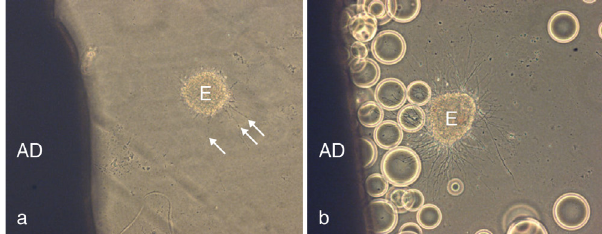
Figure 1. Diffusion-mediated degeneration of adult neocortex is inhibited by Sambucus nigra lectin. ( a ) Shows an adult cortical explant to the left (AD) and a degenerating E 15 embryonic cortical explant (E) to the right; arrows indicate blebbing of degenerating axons. ( b ) Degeneration is inhibited by placing agarose beads coated with Sambucus nigra lectin between the